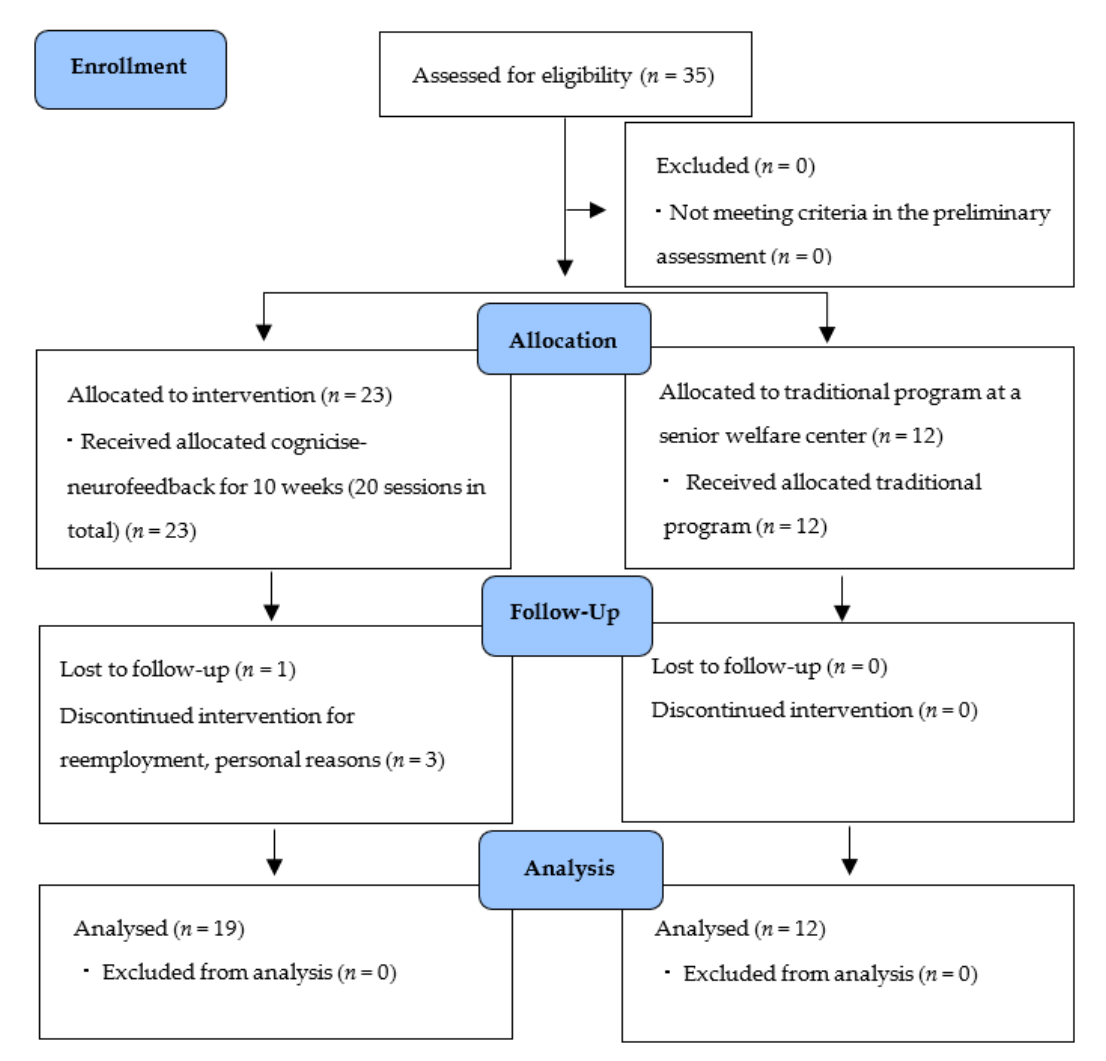
Figure 2. Flow chart.